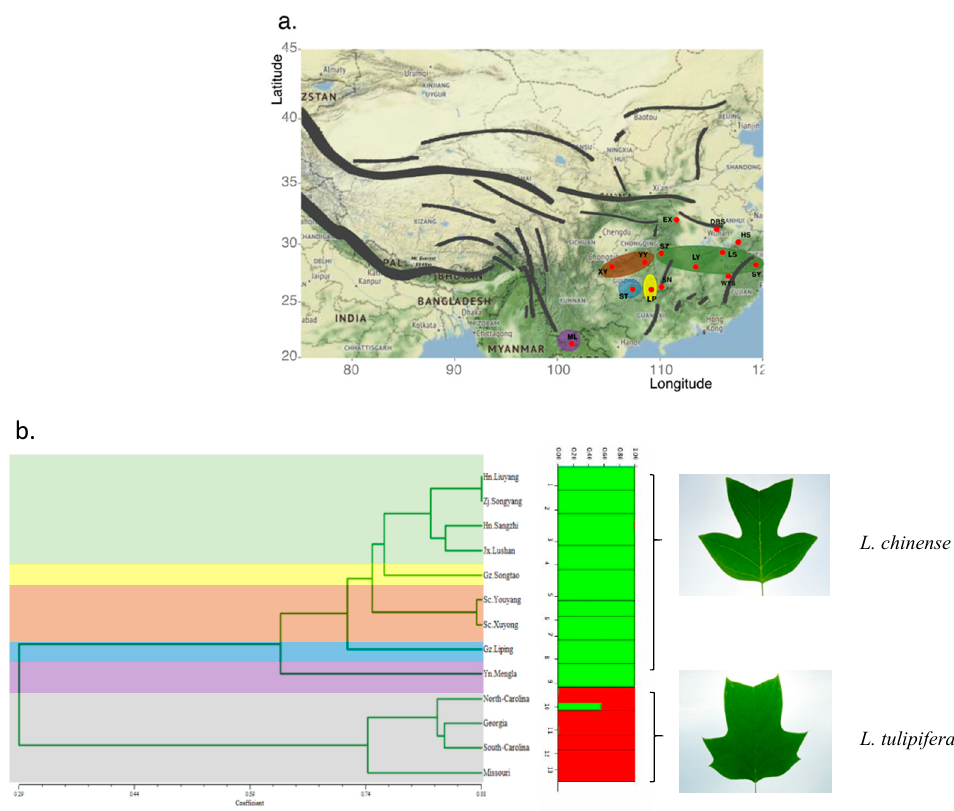
Figure 3. The UPGMA dendrogram based on Nei’s (1978) genetic distance. Bootstrap replicates = 1000. Nine L. chinense populations and four L. tulipifera populations were analyzed with a population sample size of more than three individuals. The L. chinense plants grouped into five clusters (green, Eastern China; yellow, Songtao, Guizhou Province; Orange, Sichuan Province; blue, Liping, Guizhou Province; purple, Yunan Province.). The dark lines represent the movement of the major mountain chains. The information comes from https: // zh.wikipedia.org / zh-cn / , and the mountain chains chart are redrawn based on http: // m.sohu.com / n / 484766869 / ?wp = 2. The population structure based on 13 provenances at K = 2 as determined using the ∆ K method of Evanno et